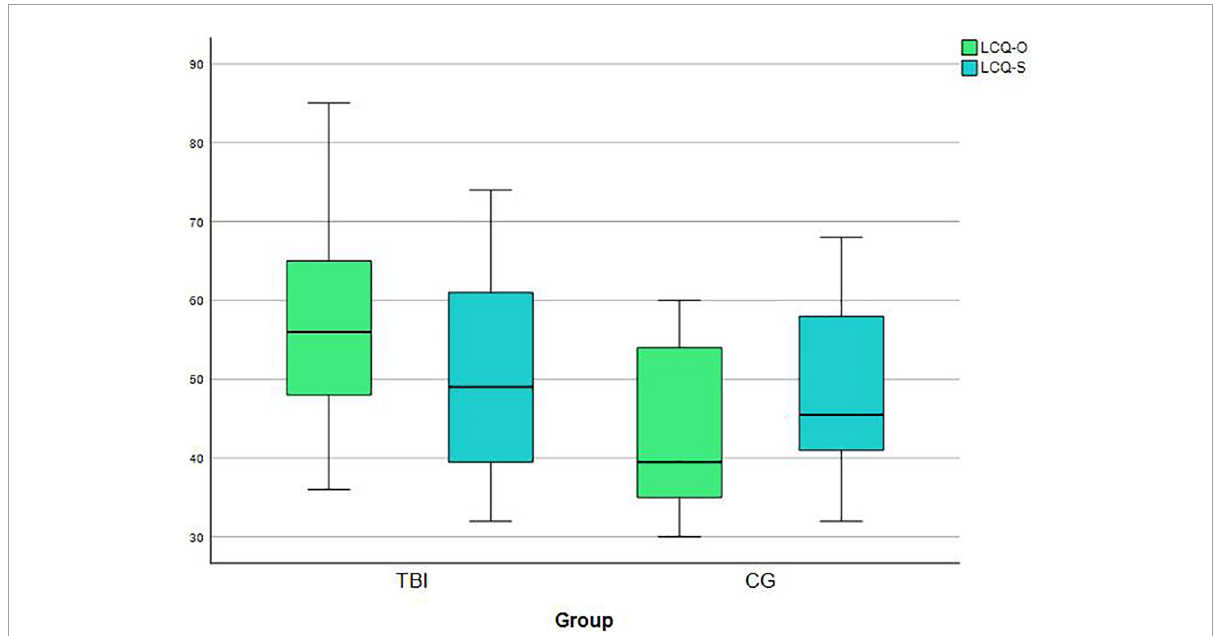
FIGURE3 Boxplots for LCQ scores for IwTBI and the Control Group in the self-assessment (LCQ-S) and in the evaluation of close-others (LCQ-O). Higher scores are reflecting greater perceived difficulties in communicative participation. Possible values are between 30 to 120 points.